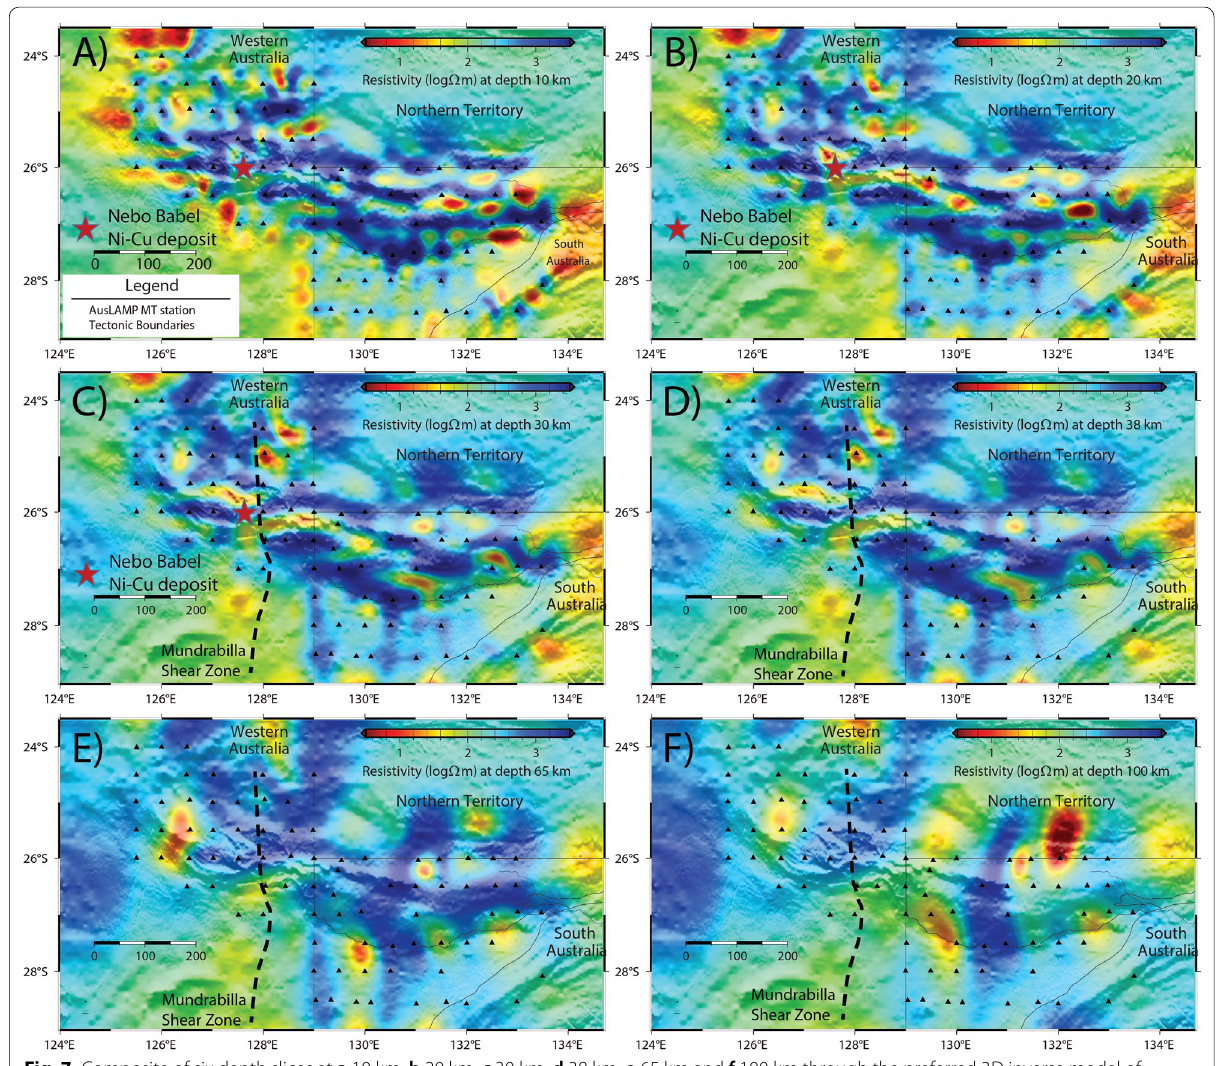
Fig. 7 Composite of six depth slices at a 10 km, b 20 km, c 30 km, d 38 km, e 65 km and f 100 km through the preferred 3D inverse model of the Musgrave Province. The resistivity distribution is shaded with the residual Bouguer gravity data across the survey area and highlights the east–west-trending gravity highs co-located with the crustal east–west-oriented conductivity anomalies (C1 at depths from 20–38 km). The West Australia, Northern Territory and South Australia state boundaries are plotted as dashed lines for location reference, with the respective state name identified. The Gawler Craton boundary and the Musgrave Province Boundary are shown as thick solid lines for reference. The red star denotes the location of the Ni–Cu Nebo Babel deposit. The Mundrabilla Shear Zone is shown as a dashed line (Aitken et al.